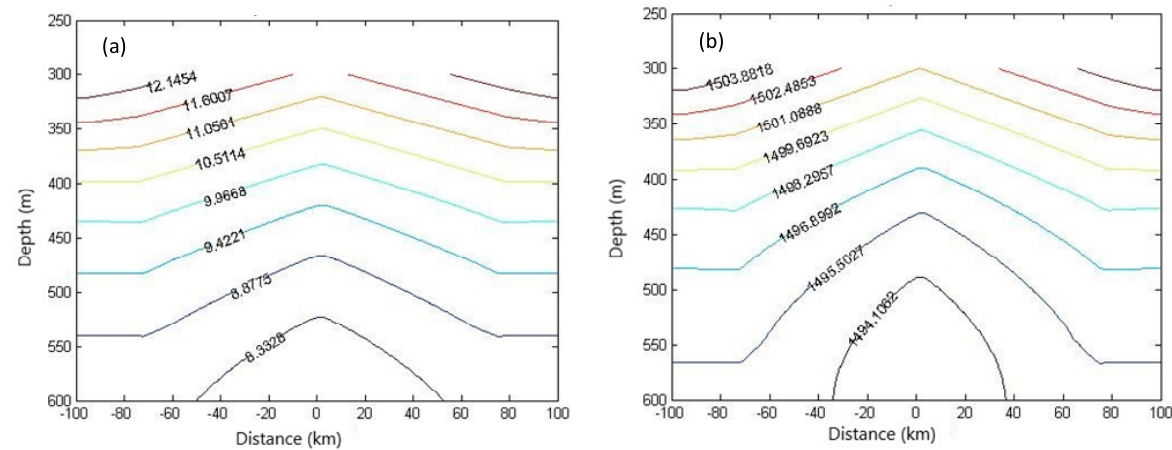
Figure 4. ( a ) Isotemperature (°C) and ( b ) Isovelocity (m/s), contour lines map at a depth range of 250 to 600 m. Table 2. Vortex parameters based on Argo Buoy data.